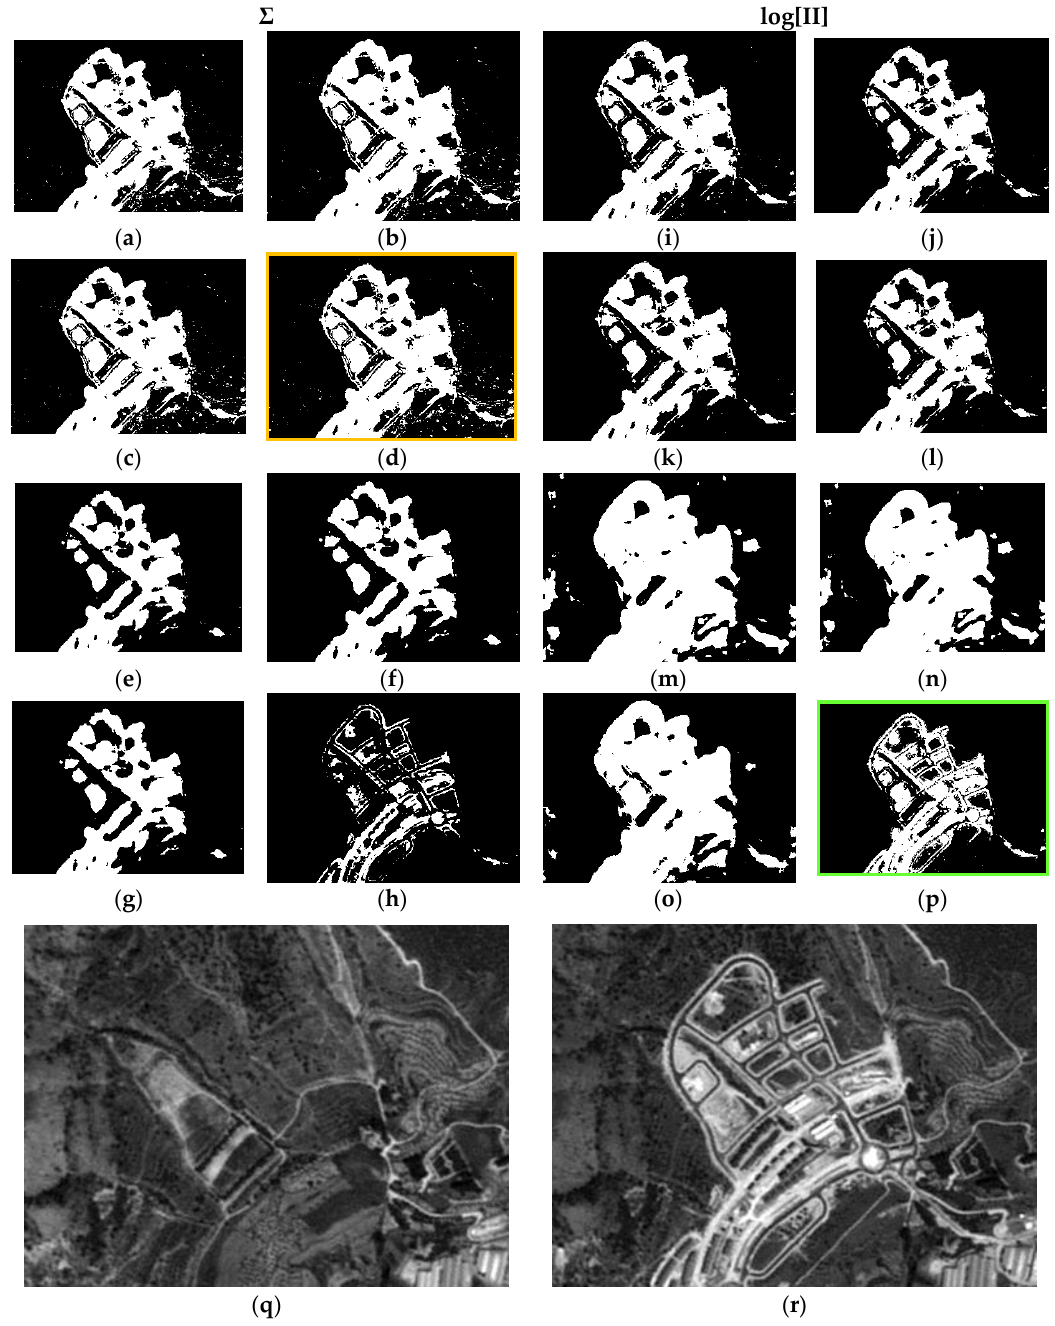
Figure 13. Probabilistic Information Fusion Results in DS2A1: ( a ) c1; ( b ) c2; ( c ) c3; ( d ) c4; ( e ) c5; ( f ) c6; ( g ) c7; ( h ) c8; ( i ) c9; ( j ) c10; ( k ) c11; ( l ) c12; ( m ) c13; ( n ) c14; ( o ) c15; ( p ) c16; ( q ) DS2A1 2005 SPOT-PAN image; ( r ) DS2A1 2008 SPOT-PAN image.